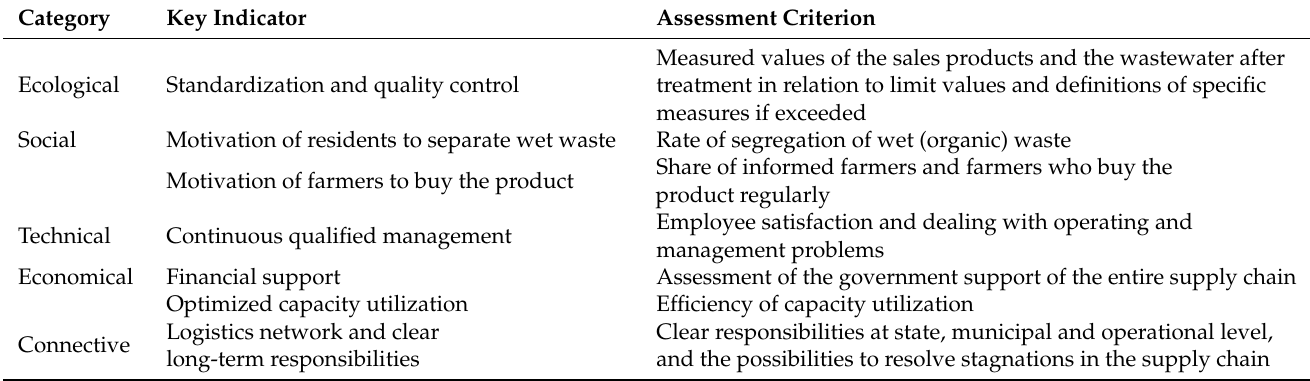
Table 2. Key indictors from stakeholder perspectives and their evaluation options, clustered in categories. The key indicators were derived from the social network analysis and summarized.